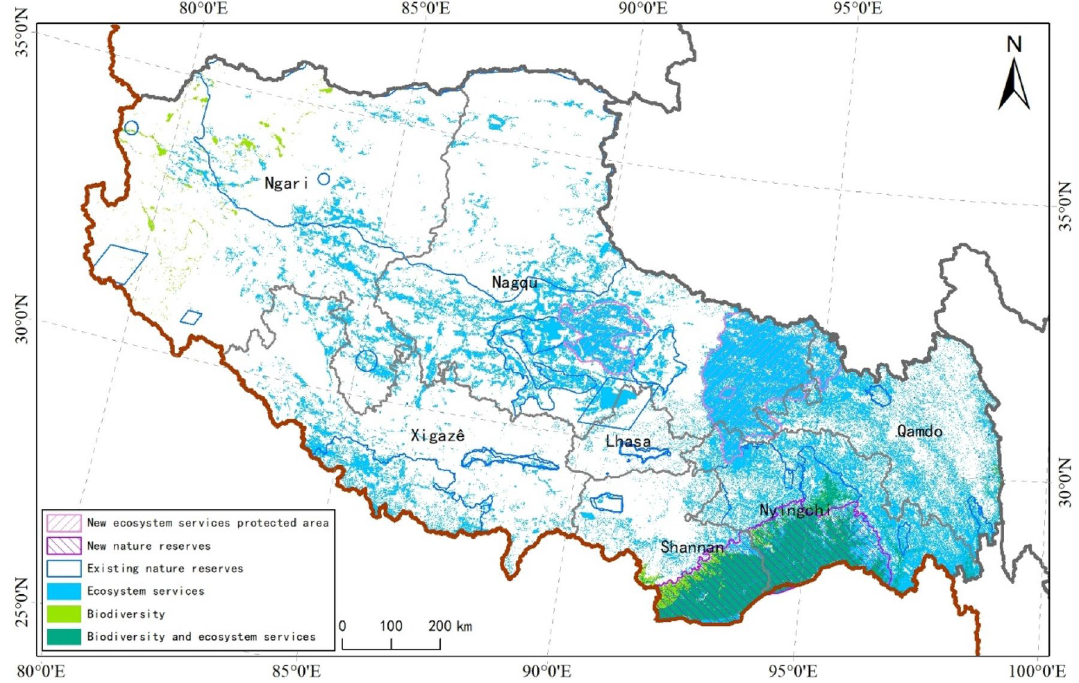
Figure 6. The system planning of Tibet Protected area based on the spatial pattern of biodiversity and ecosystem services. We created this figure in using ArcGIS 10.5 for maps (URL: http:// www. esri.